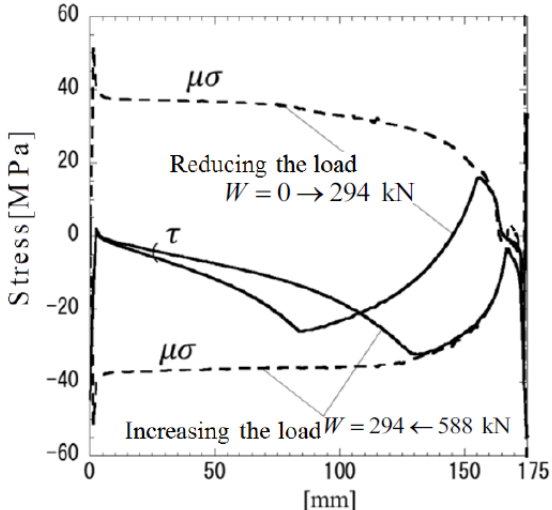
Figure 11. Shear stress τ and frictional stress µσ along arbor surface contacted with sleeve when load is changed ( µ = 0.5).